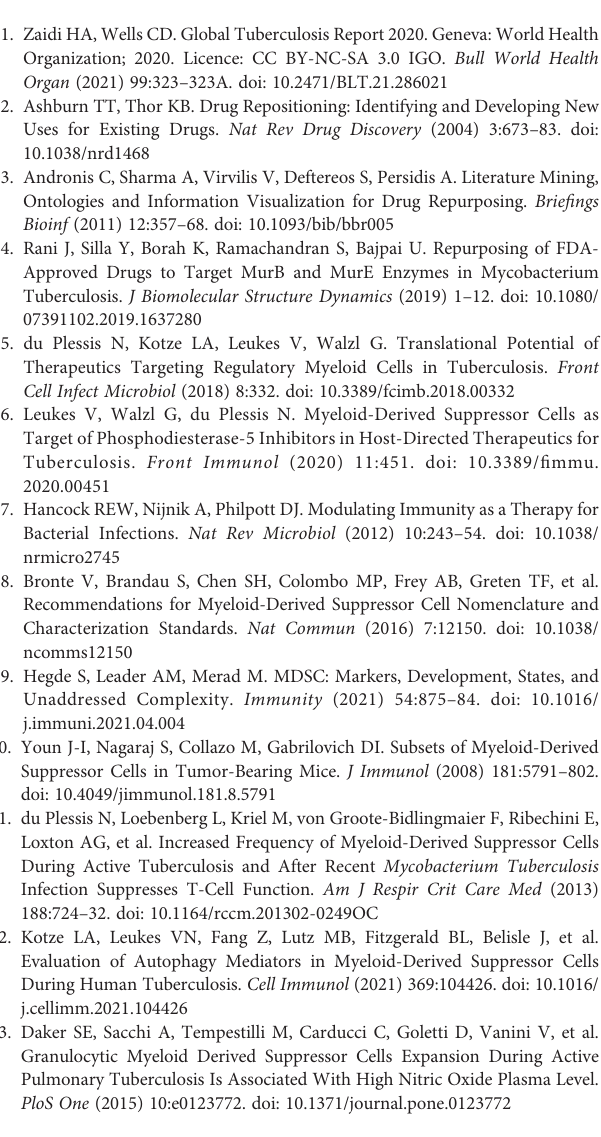
Supplementary Figure 3 | 10uM Sildena fi l treatment does not increase cGMP concentration within MDSC. cGMP concentration (pmol/ml) was measured in culture supernatant of MDSC treated with 10uM Sildena fi l for 48 hours. As positive control, cGMP was measured in culture supernatant of PBMC that were stimulated with 5ug/ml PHA for 12 hours. One-way ANOVA with Tukey post-hoc correction. Median with interquartile range indicated on plots. P<0.05 was considered signi fi